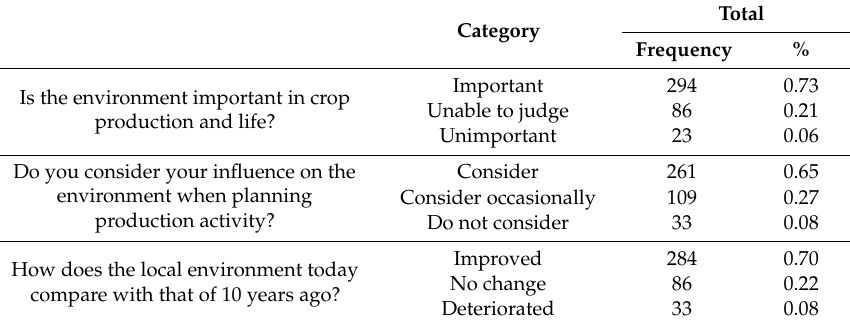
Table 6. Farmers’ awareness of the